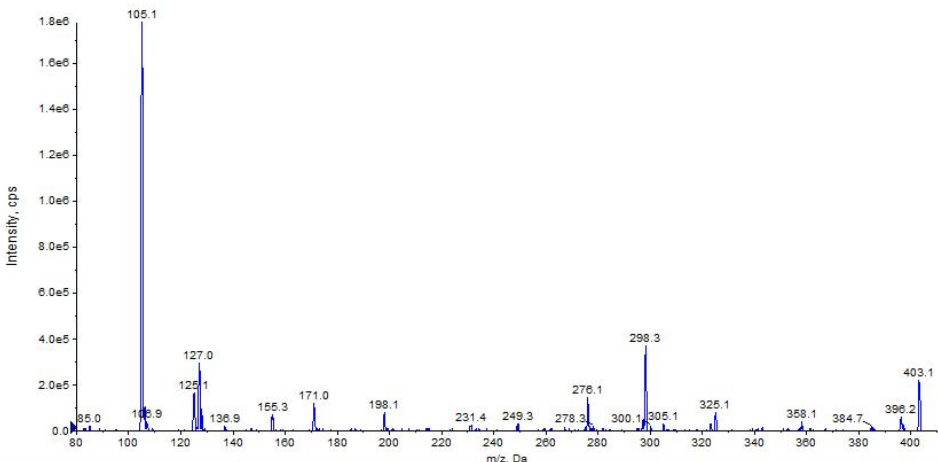
Figure 18 . Representation of the collisional-induced fragment ions of URB447 compound.